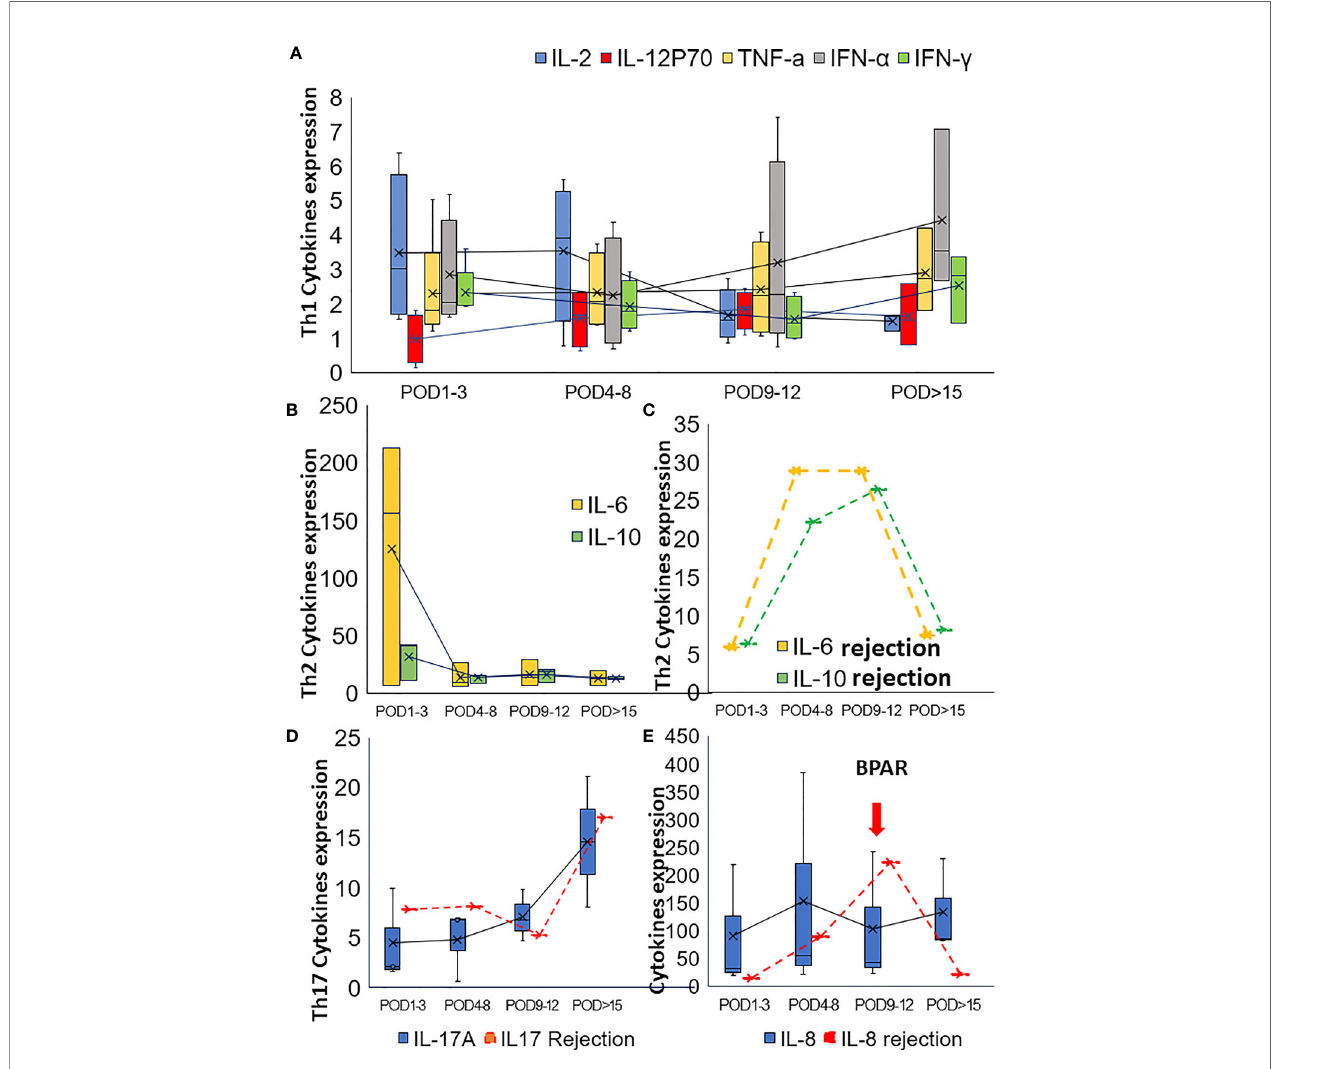
FIGURE 2 | Alteration of the cytokines in post-transplant set-up. (A) Alteration of Th1 cytokines in the post-transplant set-up; (B) The change of Th2 cytokines after transplantation for patients with neoadjuvant PD-1 blockade. (C) Alteration of Th2 cytokines (IL6 and IL10) for the patient with BPAR in cohort1. The alteration of Th17 cytokine IL17 (D) and IL8 (E) were also presented in this fi